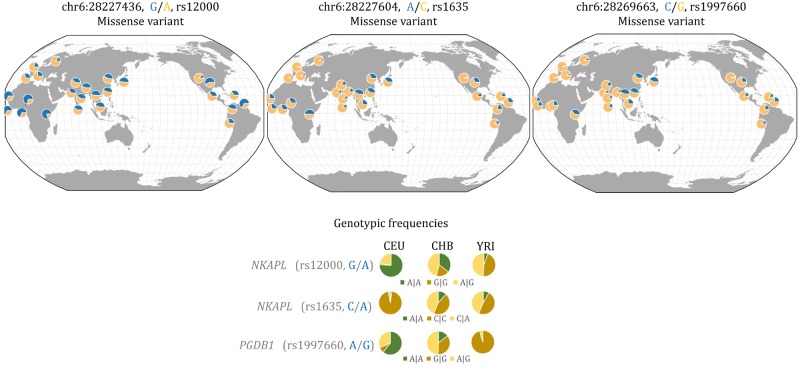
—Three missense variants located in two genes within a KRAB-ZNF gene cluster that might have undergone positive selection in European populations. Top left and middle, allelic frequencies of two nonsynonymous SNPs located in NKAPL gene. Top right, allelic frequencies of one nonsynonymous SNP located in PGDB1 gene. Bottom, genotypic frequencies for CEU, CHB, and YRI.